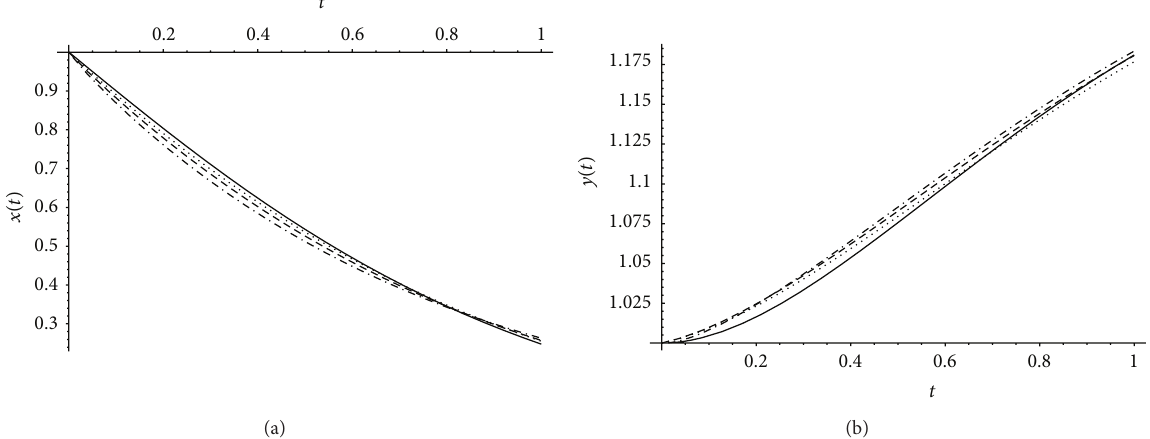
Figure 2: The exact solution (black line) and approximation solutions when 𝑚 = 12 and 𝛼 = .98 , 𝛽 = 1 (dotted), 𝛼 = .95 and 𝛽 = .99 (dashed), and 𝛼 = .9 and 𝛽 = .98 (Long-dashed).